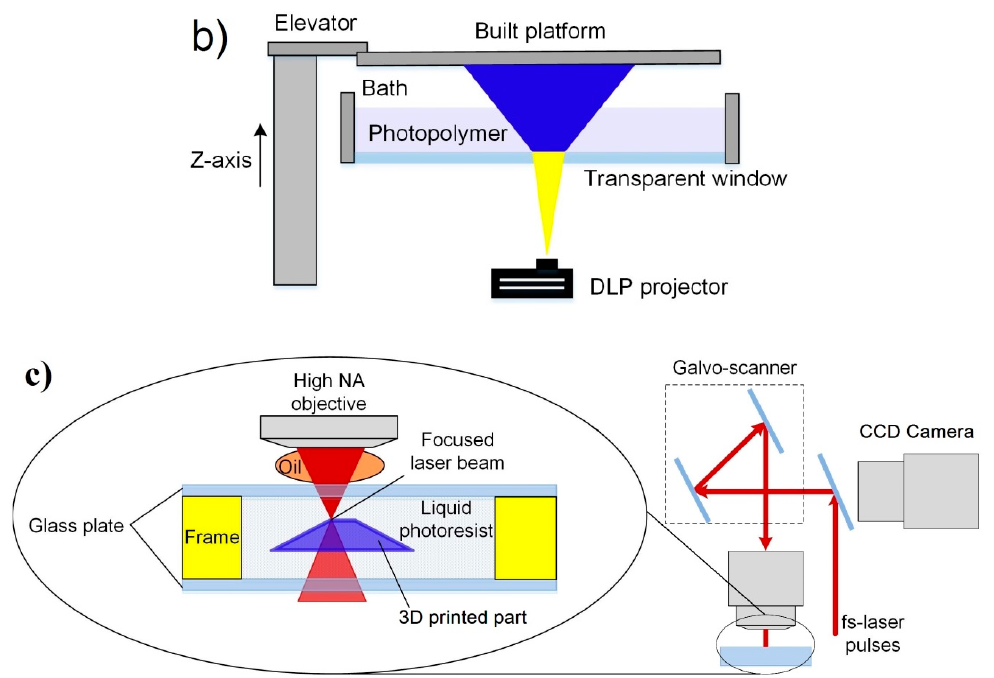
Figure 3. Schematic diagrams of slurry-based AM technologies main methods: ( a ) SLA; ( b ) DLP; ( c ) two-photon polymerization (TPP). Figure 3 a , b adapted from [44], with permission from Wiley-VCH Verlag GmbH & Co. KGaA, Weinheim, 2018.